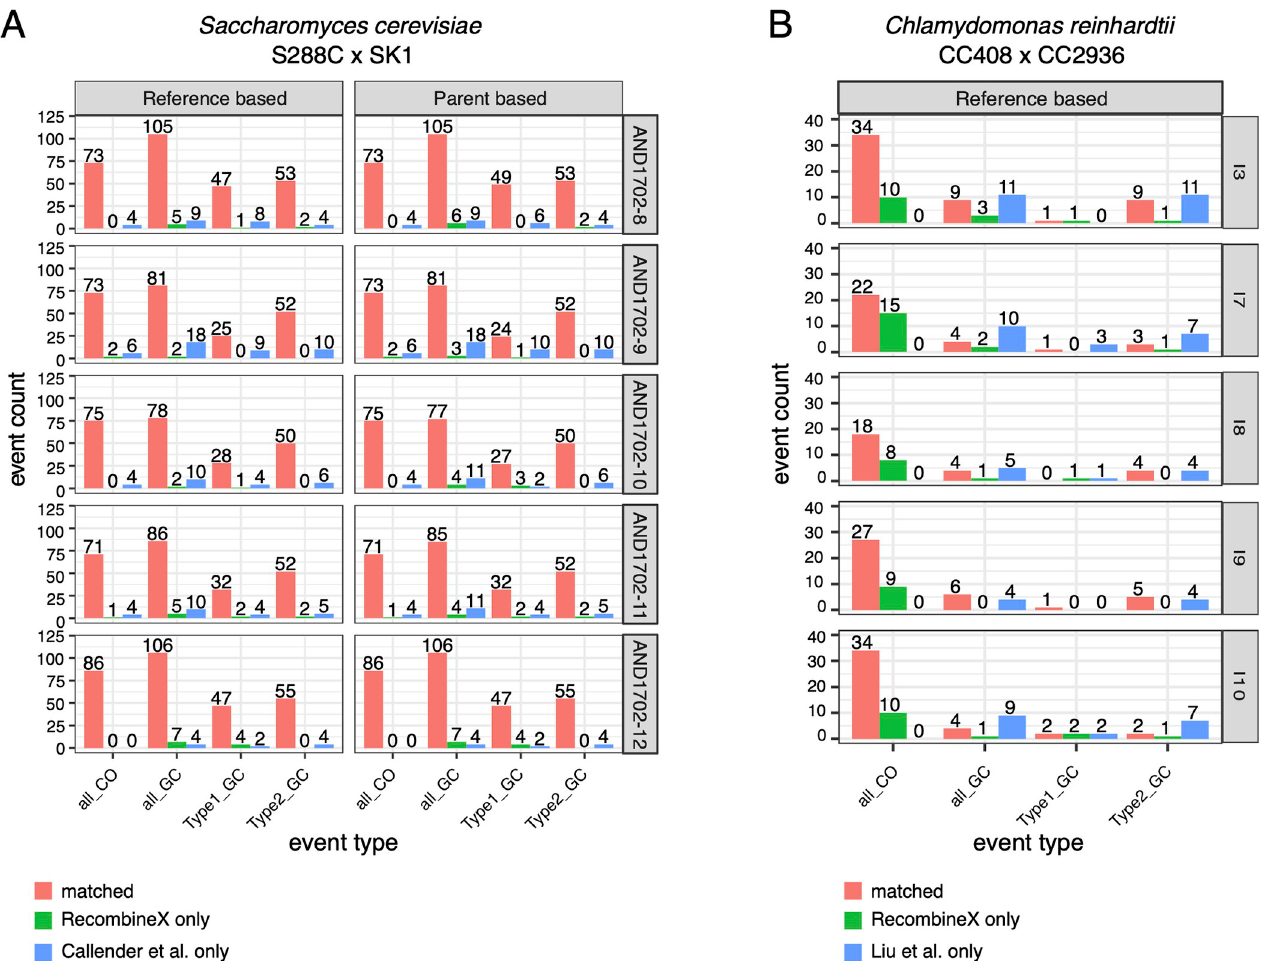
Fig 6. Applying RecombineX to real yeast and green alga tetrads for recombination profiling. Previously sequenced tetrads from yeast (AND1702-8, AND1702-9, AND1702-10, AND1702-11, AND1702-12) and green alga (I3, I7, I8, I9, I10) were used for re-processing with RecombineX, the results of which were further compared with the original studies (Callender et al. for the yeast example and Liu et al. for the green alga example). (A) The number of matched and unmatched total CO, total GC, Type 1 GC (NCO), and Type 2 GC (CO-associated GC) events identified by RecombineX (in both reference-based and parent-based modes) compared with the original study (Callender et al.) based on the yeast tetrad sequencing data. (B) The number of matched and unmatched total CO, total GC, Type 1 GC (NCO), and Type 2 GC (CO-associated GC) events identified by RecombineX (in reference-based mode) compared with the original study (Liu et al.) based on the green alga tetrad sequencing